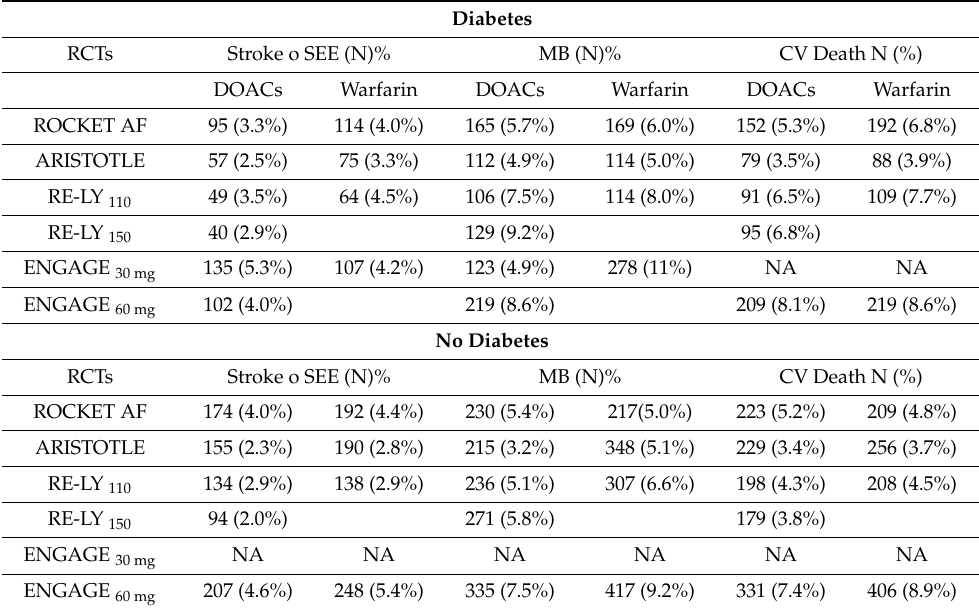
Table 4. Stroke/systemic embolism, major bleeding, and cardiovascular death in patients with and without diabetes in the pivotal trials.